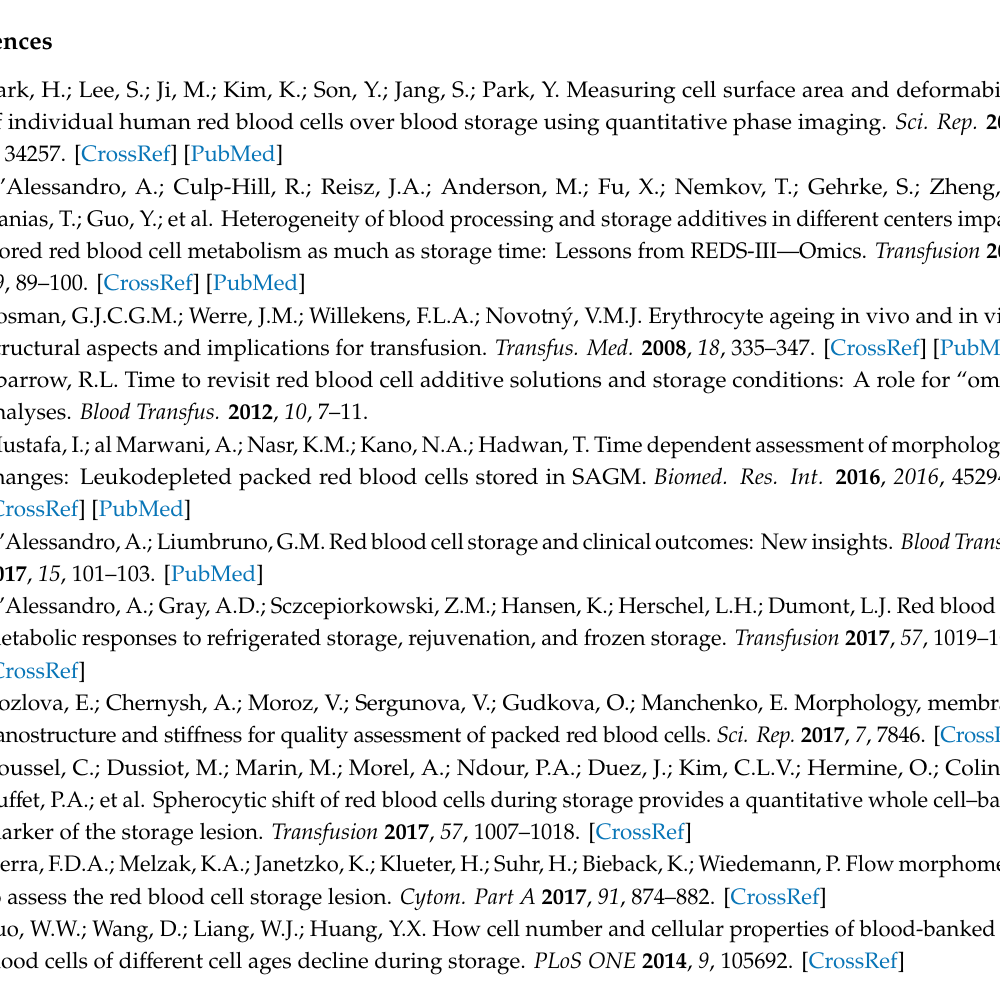
Figure A3. Measurement of axial ( D A ) and transverse ( D T ) diameters of a RBC at equilibrium cell stretched